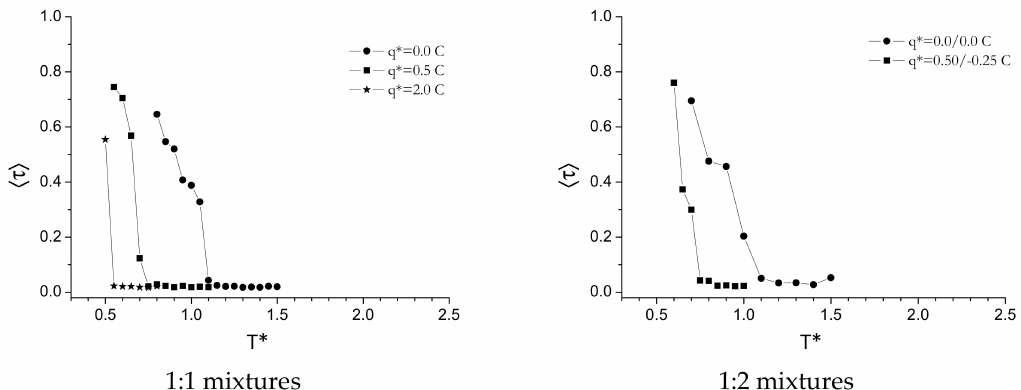
Figure 2. Dependence of the orientational order parameter, (cid:104) P 2 (cid:105) , (top panels) and translational order parameter, (cid:104) τ (cid:105) , (bottom panels) on the scaled temperature, T *. The left panels refer to the 1:1 stoichiometry; the right panels to the 1:2 stoichiometry. Packing fraction η * = 0.371. H and C refer to heating and cooling runs,